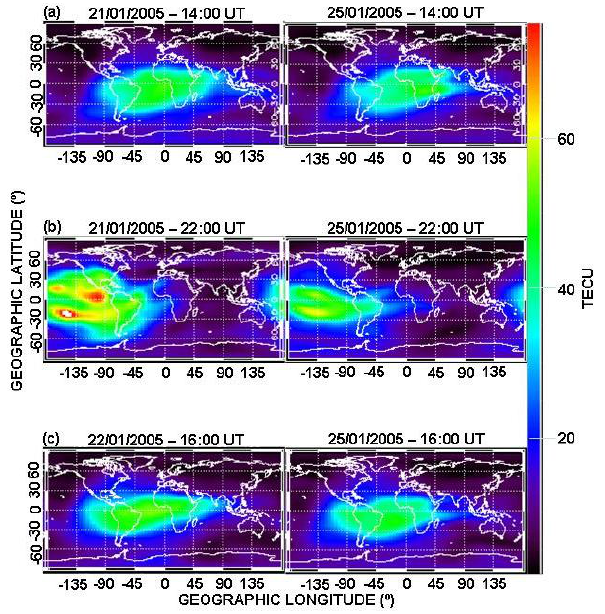
Fig. 10. Three GPS-TEC maps for 21 and 22 January (14:00UT – before the storm; 22:00UT – during the storm; 16:00UT – re- covery phase) (left hand column) and three GPS-TEC maps for 25 January geomagnetically quiet (right hand column) conditions for